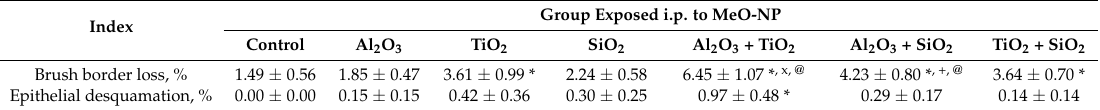
Table 4. Morphometric Indices of Damage to the Epithelium of the Proximal Convoluted Tubules in Rat Kidneys after Subchronic Exposure to Al 2 O 3 -NP, TiO 2 -NP and SiO 2 -NP Individually or in Binary Combinations (x ± s.e.).